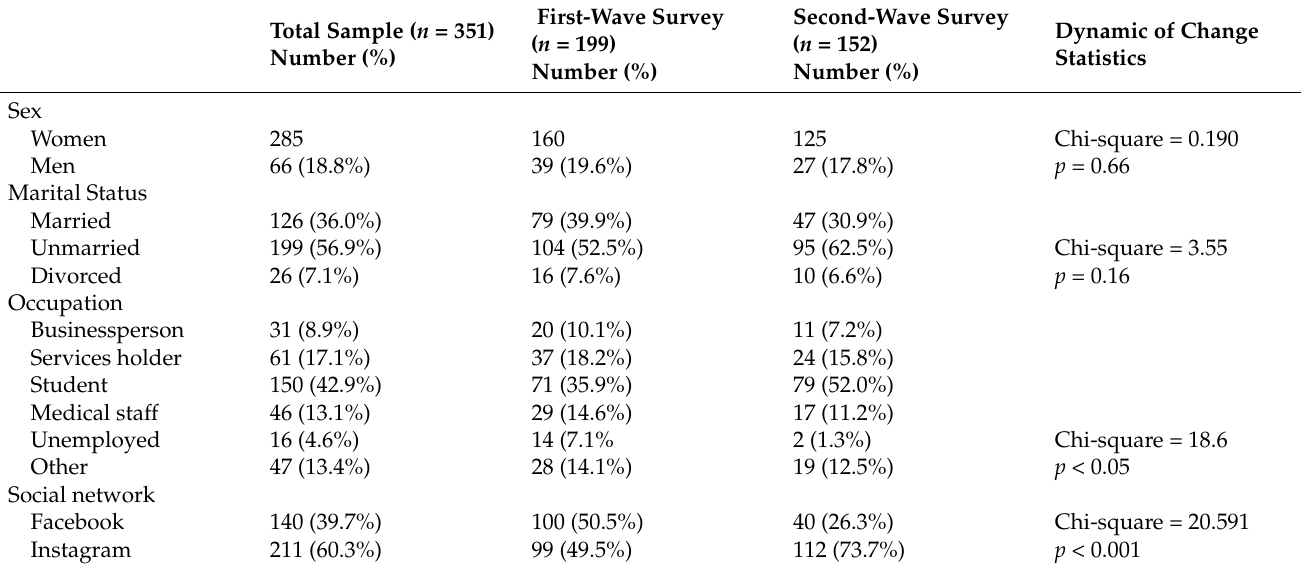
Table 2. Ethnography of participants in the study and each